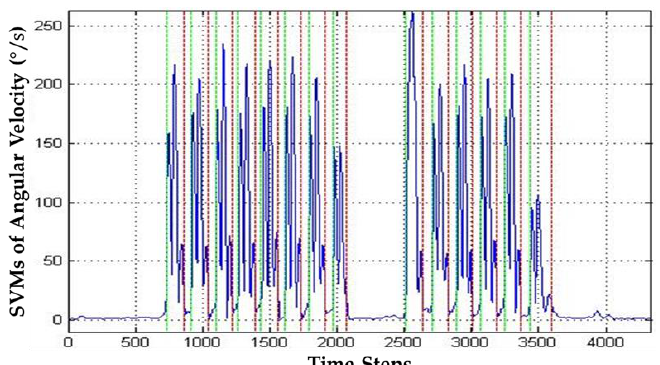
11 of 21 Figure 11. Wearable motion sensing device mounted on foot. Figure 12. Block diagram of the indoor positioning algorithm.